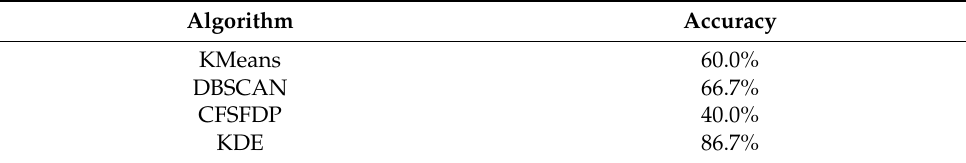
Table 8. The accuracy of each algorithm in the classification of hotspot.